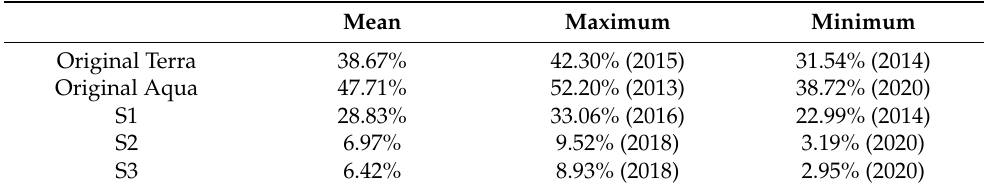
Figure 6. Cloud removal results for Wuliangsu Lake in 2017. ( a ) Original Aqua MODIS; ( b ) after S1 calculation; ( c ) after S2 calculation; ( d ) after S3 calculation ( C ( t ) , W ( t ) , and I ( t ) denote cloud, water, and ice coverage, respectively; C ( t ) denotes the mean cloud coverage. The underlined box marks high C ( t ) ). Table 1. Comparison of cloud cover with and without cloud removal for Wuliangsu Lake from 2013 to 2022.